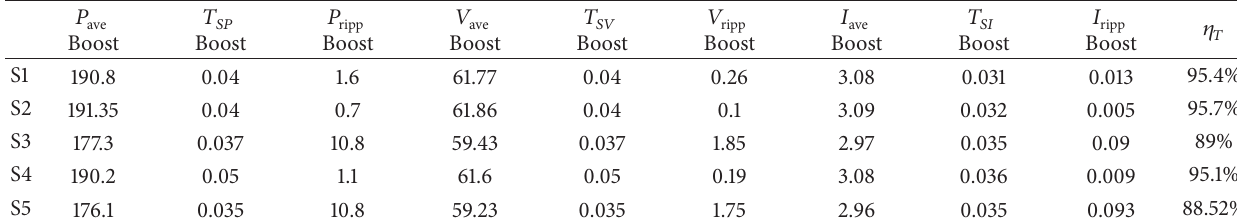
Table 8: The simulation values for boost converter